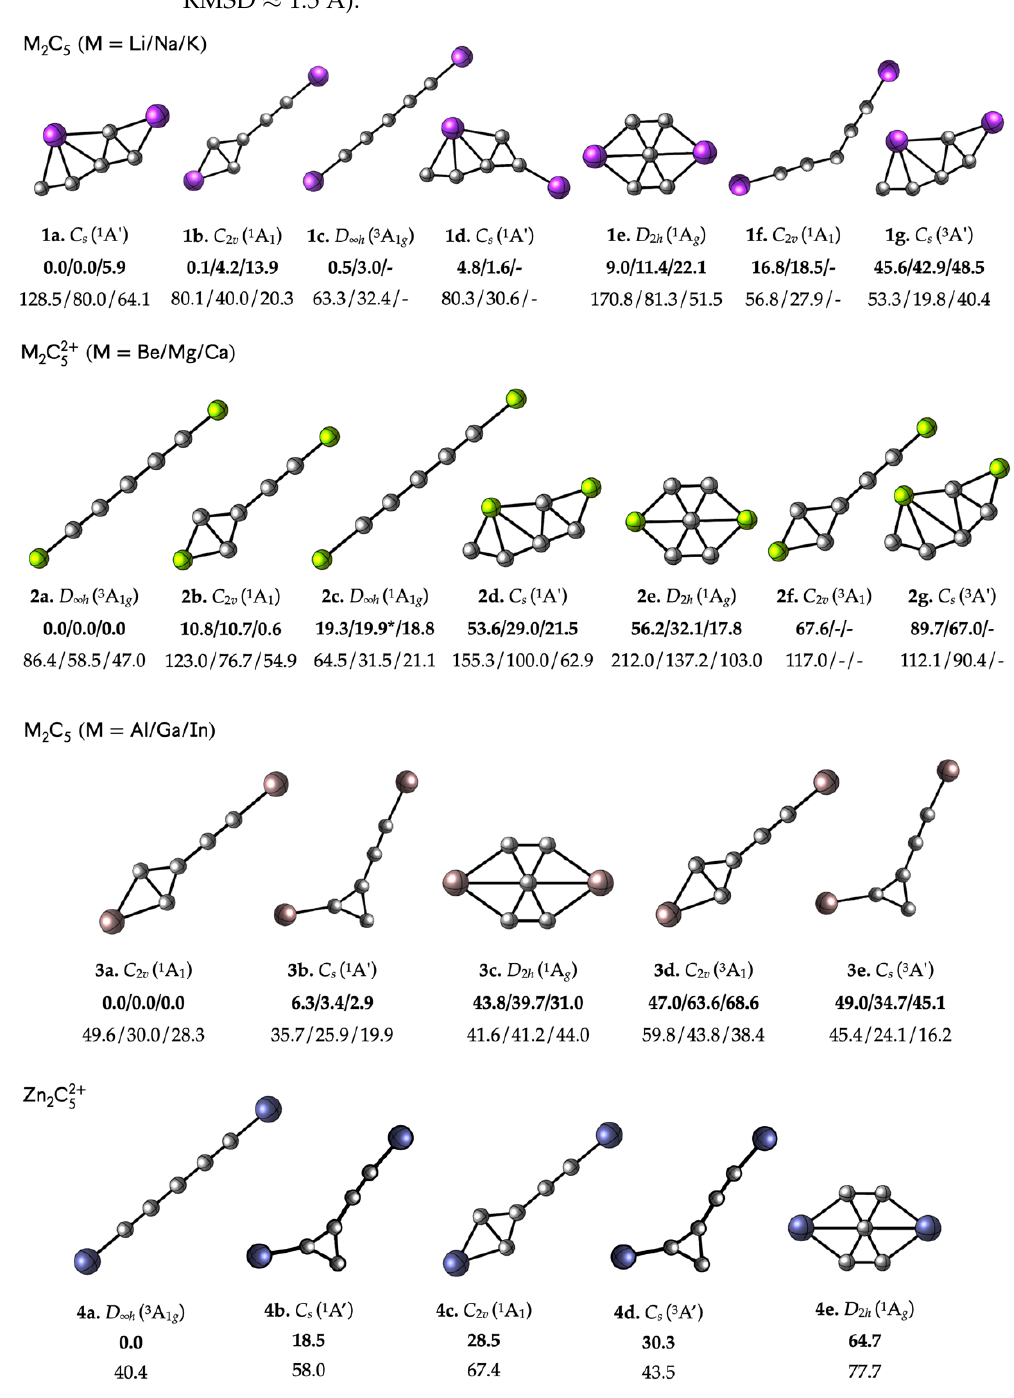
Figure 2. Putative global minimum and low-lying isomers of M 2 C 50/2+ (M = Li-K, Be-Ca, Al-In, and Zn) clusters with their point group symmetries. Relative energies, including zero-point energy (ZPE) corrections in kcal·mol −1 ( in bold ) and their lowest harmonic vibrational frequency in cm −1 (below) at ωb97XD/Def2 -TZVP level, are also shown. Cartesian coordinates of phC structures are depicted in Table S1. * The 2c structure for M = Mg is slightly bent in the center; therefore, it has a C 2v symmetry.